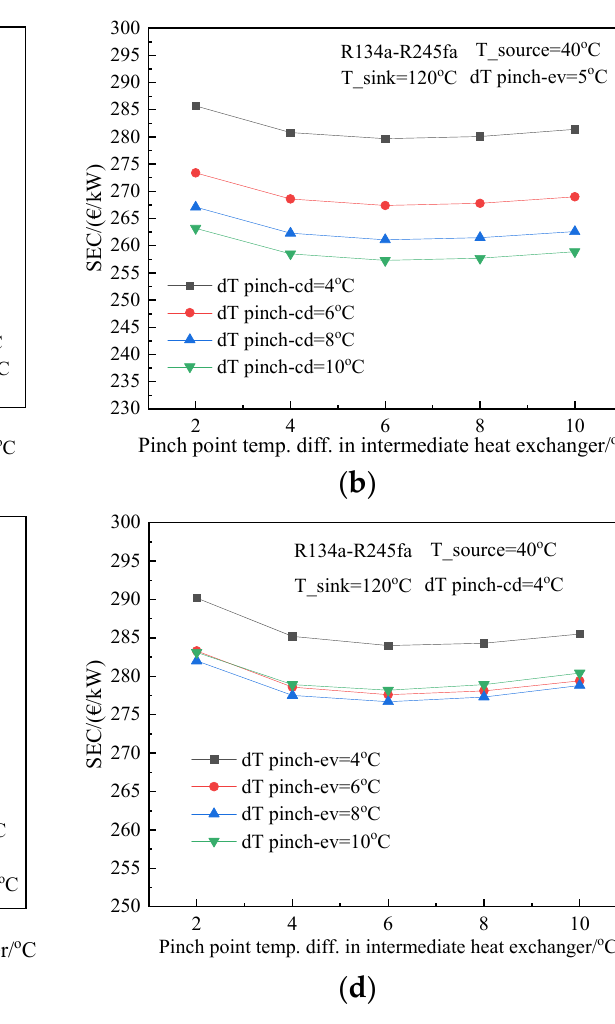
Pinch point temp. diff. in intermediate heat exchanger/ o C